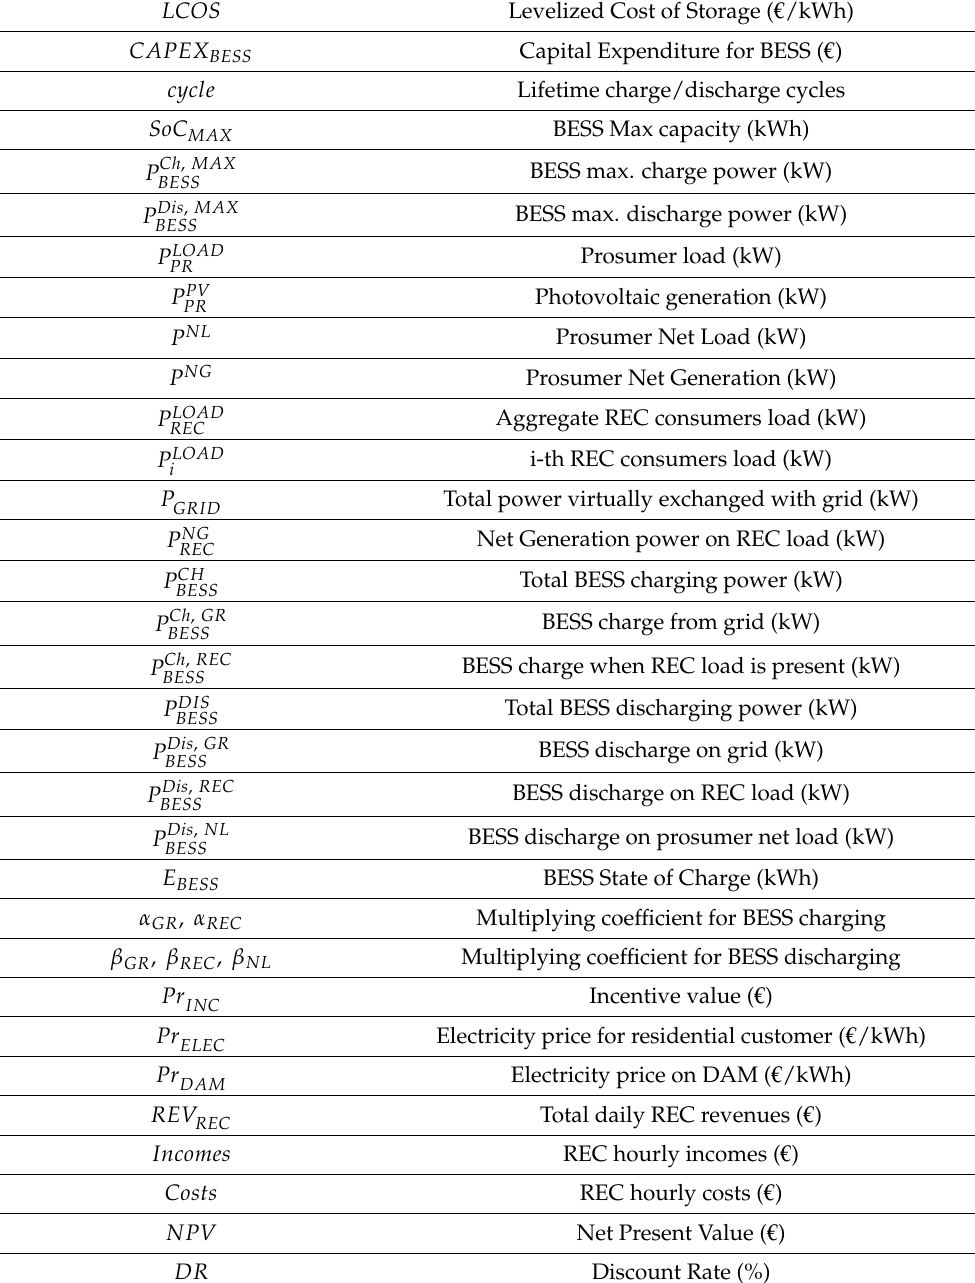
Table 2 below summarizes the nomenclature used in this section: Table 2.